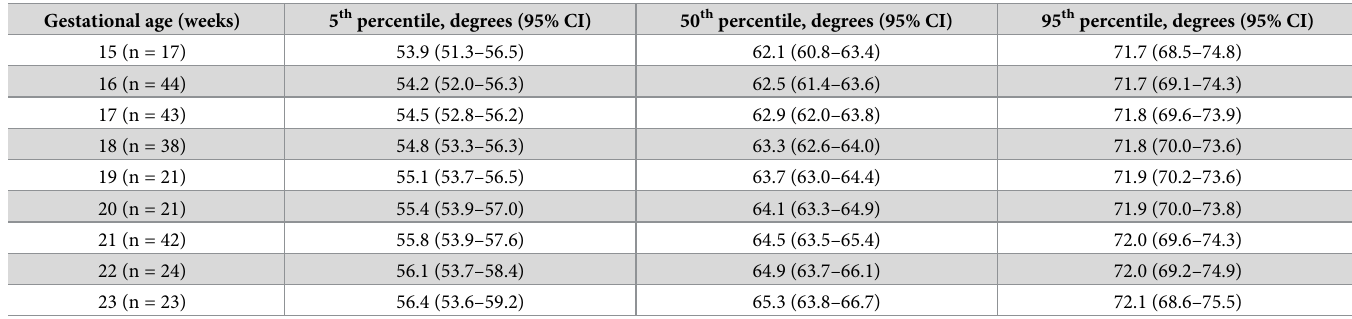
Table 2. Reference range of inferior facial angle (IFA) as estimated by the quantile regression analysis with 95% confidence interval along gestational age (N = 273).